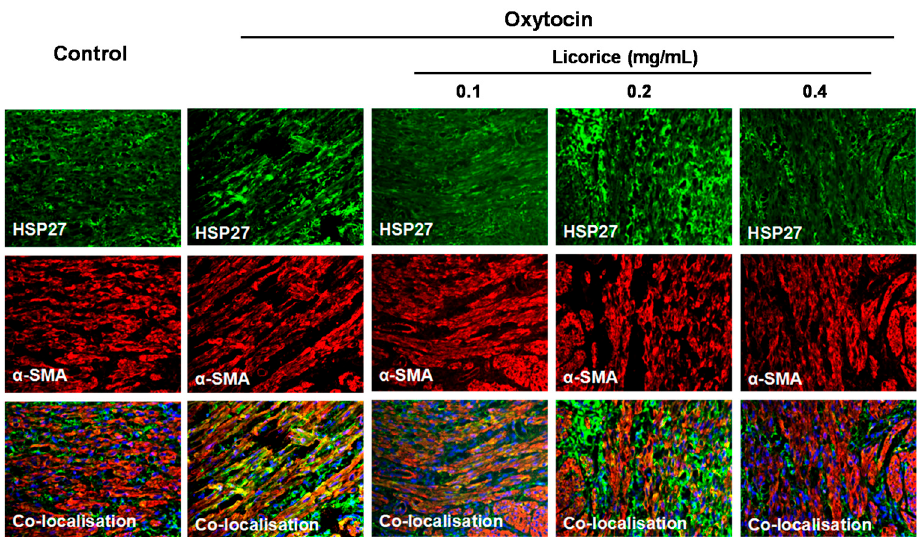
Figure 5. Effects of licorice aqueous extract on the colocalization of HSP27 with α -SMA in oxytocin-stimulated uterus. Representative immunofluorescence microscope images of HSP27 (green), α -SMA (red) and colocalization regions (yellow) with DAPI-stained nuclei (blue) in the myometrial tissues were generated using Leica Microsystems (Leica DM2500, Wetzlar, Germany) with a scale bar of 20 μ M ( n = 3).